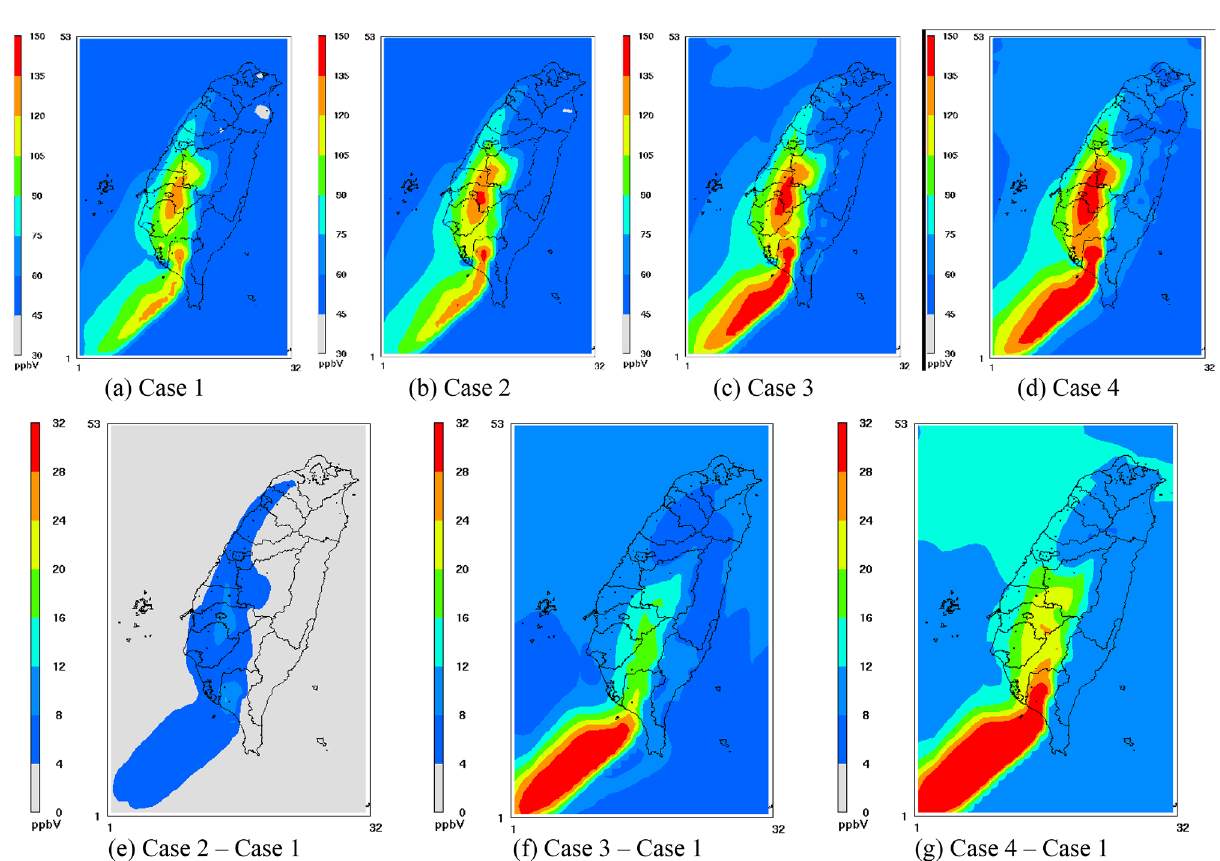
Figure 5. Isopleths of the O 3 level at 2 pm on May 27, 2003, in Domain 3 [the figures are produced with Package for Analysis and Visualization of Environmental data (PAVE) v2.3.2, http://paved .sourc eforg